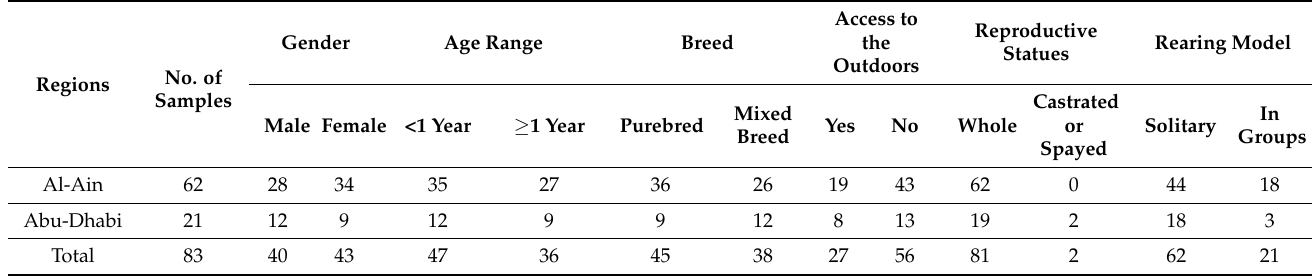
Figure 1. United Arab of Emirates (UAE) map showing Al-Ain and Abu-Dhabi cities (in green circles) involved in this study. Table 1. Details of collected samples from cats’